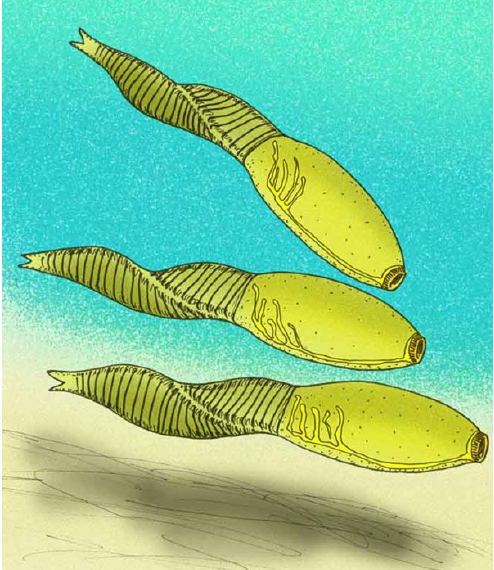
Figure 7. Banffia constricta . Length of animal 10 cm. PaleoArt credit: Apokryltaros. Used here per CC BY-SA 3.0.